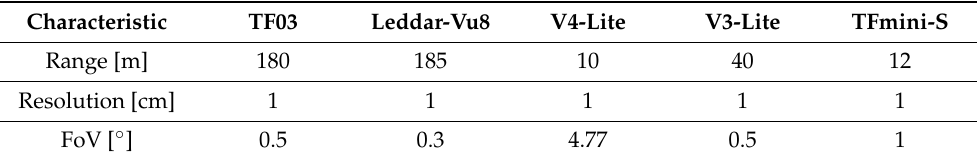
Table 1. Main characteristics of several narrow-field-of-view LiDAR. Characteristic TF03